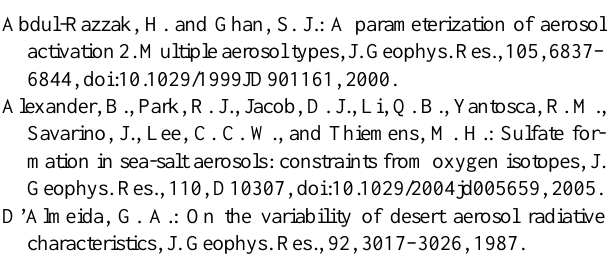
table particles. Sensitivity calculations are demonstrated us- ing the GMI and GEOS-Chem 3-D global CTMs. CDNC is more sensitive to updraft velocity and uptake co- efficient over land and polluted marine environments and less sensitive to those parameters over pristine environments